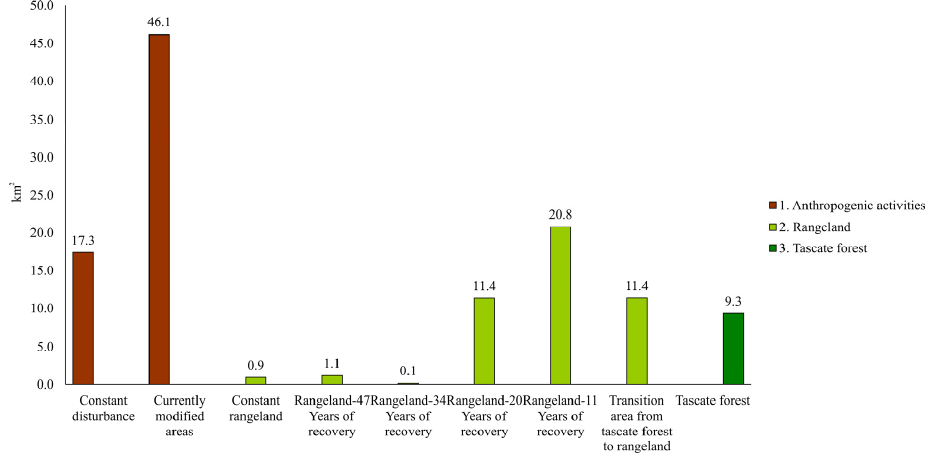
Figure 21. Represented area (km 2 ) for each category of land use coverage during the study period, El Llano y Anexas, Bustamante, Tamaulipas, Mexico.